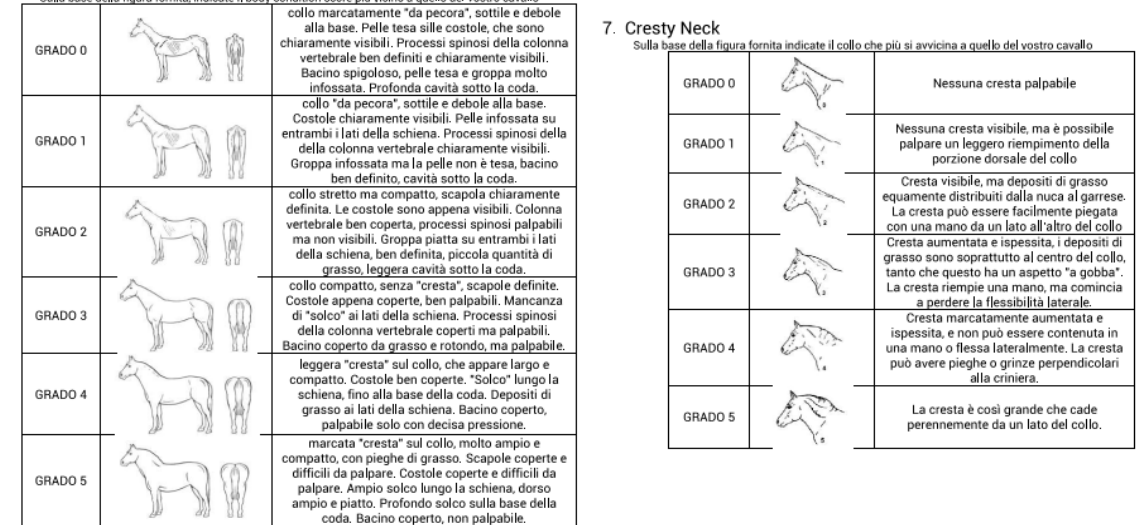
Figure 1. Diagram presented to the owners and the vet to evaluate BCS and CNS of the horses in the study. Modified from Refs. [18,19]. study. Modified from Refs.